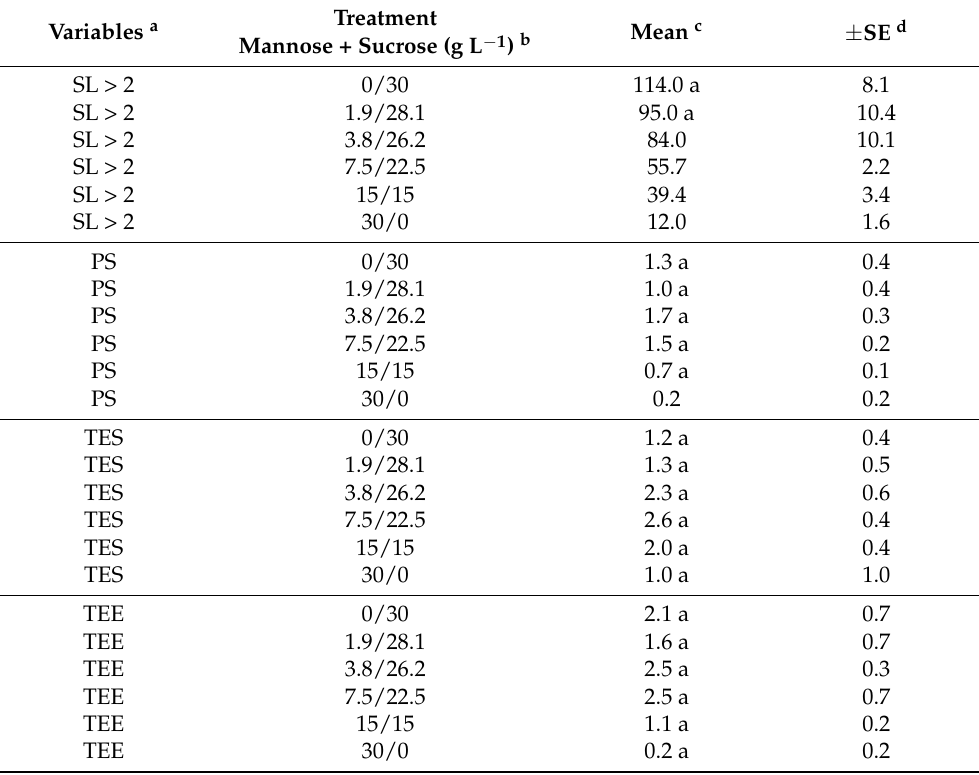
TEE 30/0 0.2 a Variables: SL > 2, shoot length greater than 2 mm; PS, positive shoots; TES, transformation efficiency based on the number of screened shoots; TEE, transformation efficiency based on the number of explants; b Treatment, g mannose + g sucrose; c Mean of 6 replicates; d ± SE, ± standard error. Means with the same letter are not significantly different from the sucrose control at the 5% level. For the CsPMI2 vector and the SL>2 variable, treatments two (1.9 g L − 1 mannose + 28.1 g L − 1 sucrose) and three (3.8 g L − 1 mannose + 26.2 g L − 1 sucrose) were similar to the sucrose control (0 g L − 1 mannose + 30 g L − 1 sucrose), whereas mean shoot lengths in sucrose), and six (30 g L − 1 mannose + 0 g L − 1 sucrose) were significantly reduced (Table 4). For the mean PS variable, treatment six (30 g L − 1 mannose + 0 g L − 1 sucrose) was